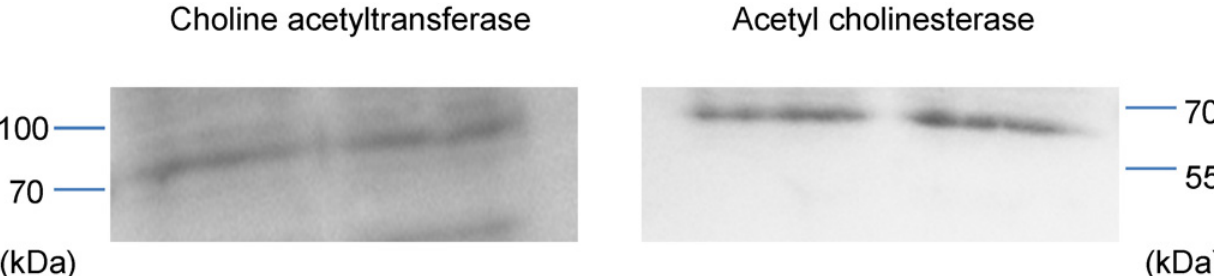
Fig 3. Representative western blot analysis of NT2.N/A cell lysate proteins. The cholinergic markers choline acetyltransferase (ChAT) and acetylcholinesterase (AChE) were detected in NT2.N/A cell lysates (10 μ g/well).